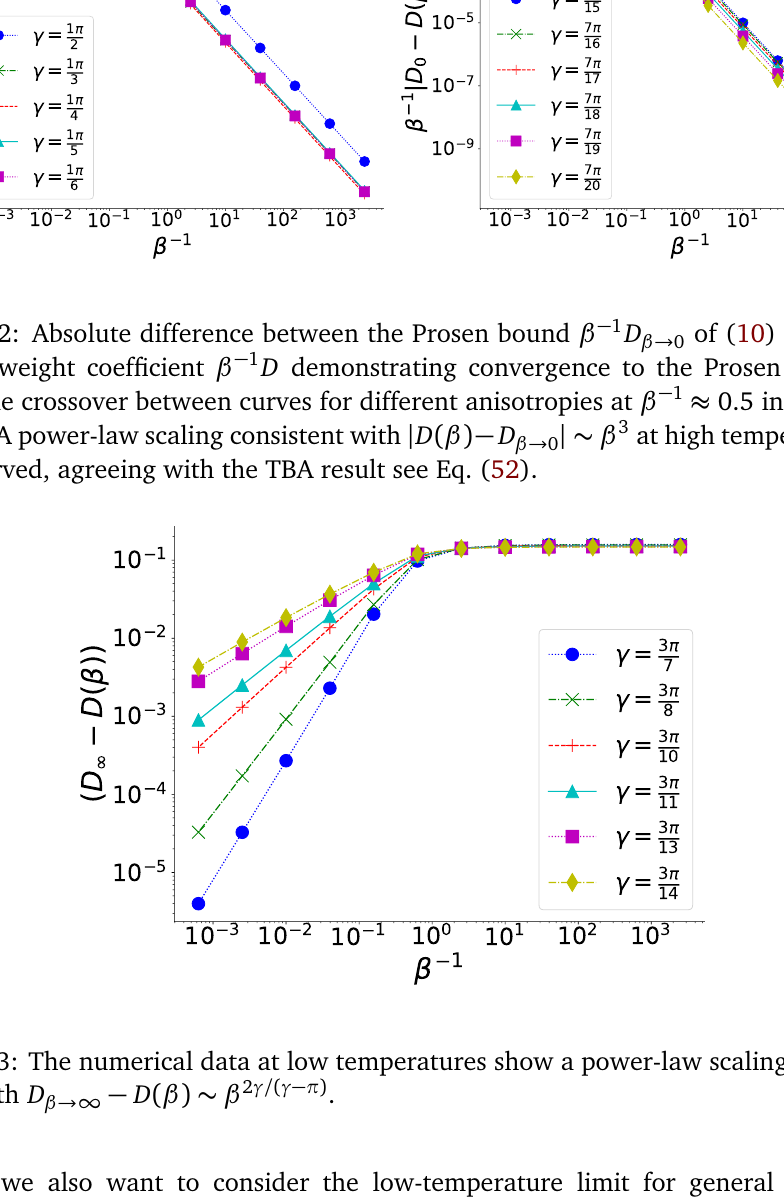
Figure 3: The numerical data at low temperatures show a power-law scaling consis- tent with D β →∞ − D ( β ) ∼ β 2 γ/ ( γ − π )